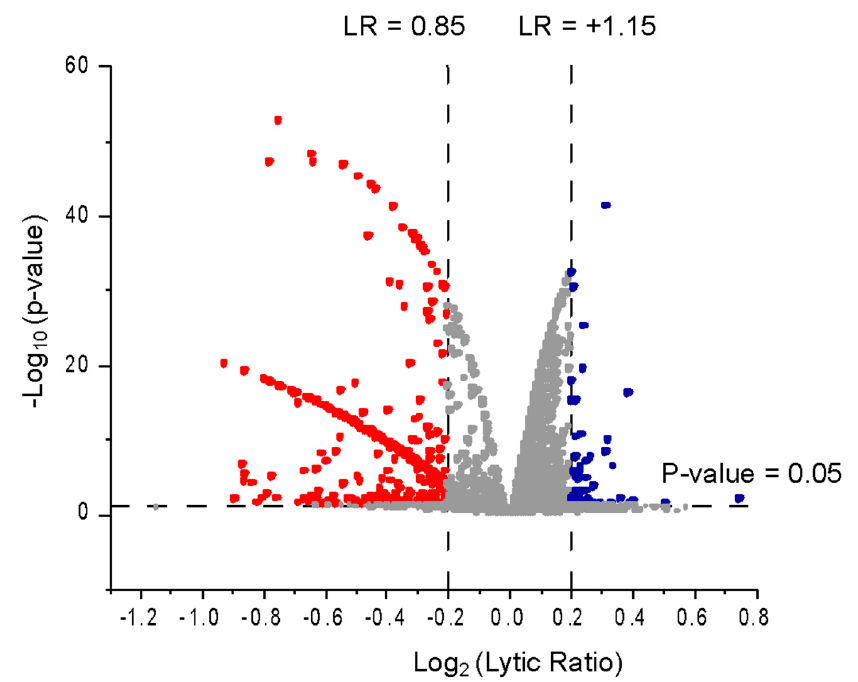
Figure 2. Screening results as a volcano plot. Results are displayed as a volcano plot with the log 2 -transformed lytic ratio on the x-axis and the − log 10 -transformed p -value on the y-axis. Positives (blue) had a lytic ratio >1.15 (log 2 transformed: 0.20163) and a p -value < 0.05. Compounds that